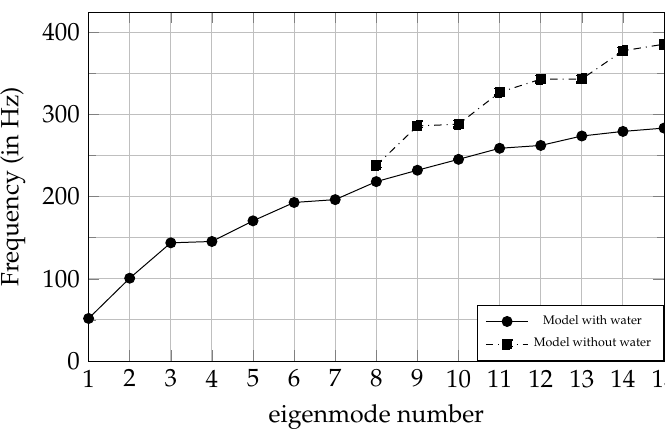
Figure 14. Added mass effect at the draft